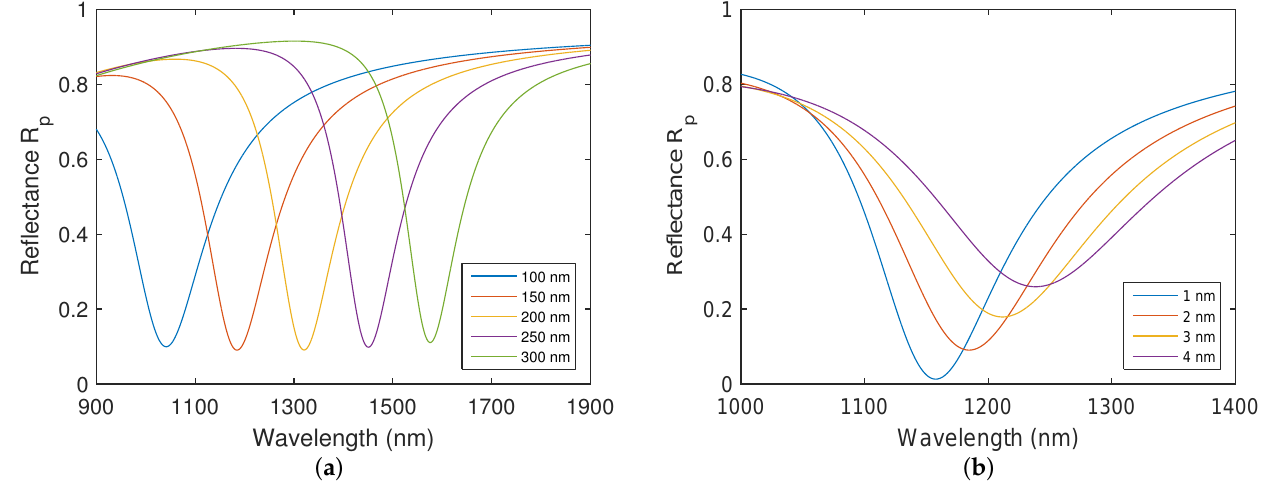
Figure 2. Theoretical spectral reflectance R p ( λ ) for distinct gold layer thicknesses for: t SiO = 300 nm ( b ). Angle of incidence θ = 68 ◦ . Chromium layer thicknesses t ( a ), t SiO 2 The analyte is water.